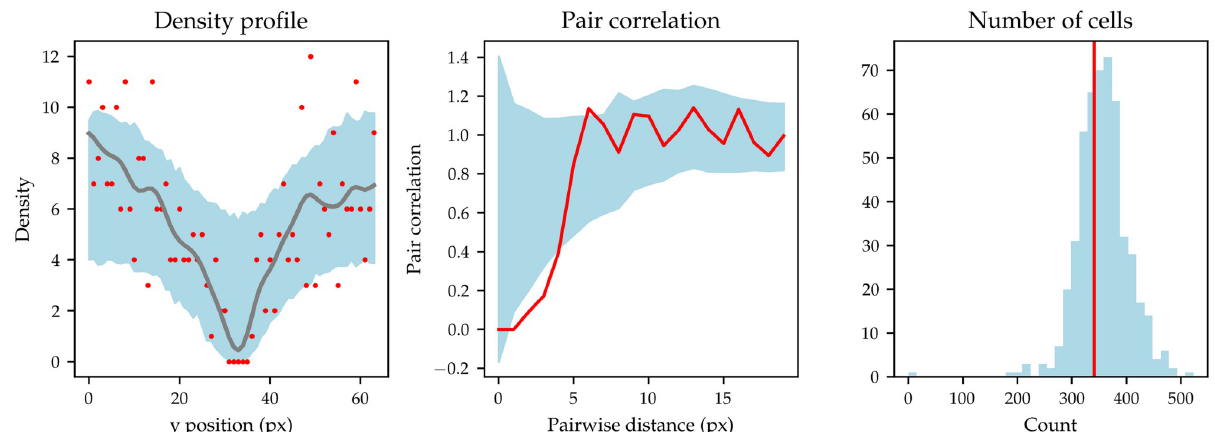
Fig 3. Posterior predictive check for the model. Left: experimentally observed density profile for a single datapoint sampled at random from the Mock dataset (red points) displayed against the posterior range of one standard deviation away from the posterior mean (blue shaded region). The gray line is the smoothed density profile generated using a Gaussian kernel. Middle: experimental pair correlation function (red line) displayed against the posterior range away of one standard deviation away from the posterior mean (blue shaded region). Right: experimentally observed cell count at t = 24 h (red vertical line) compared to the histogram of model simulations of cell count (blue). All summary statistics have an excellent fit to the experimental data.